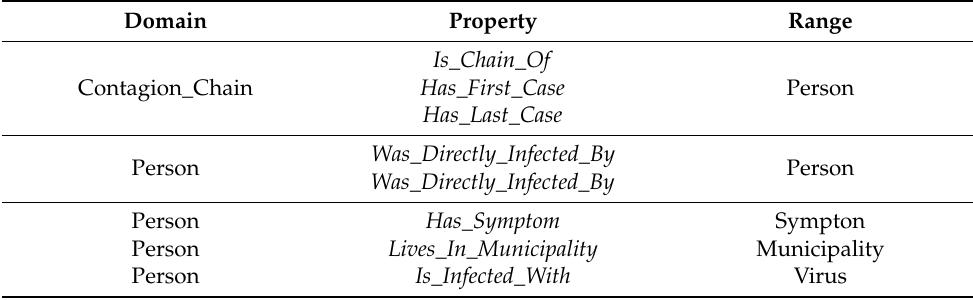
Table 1. Object properties of the classes Person and Contagion_Chain.